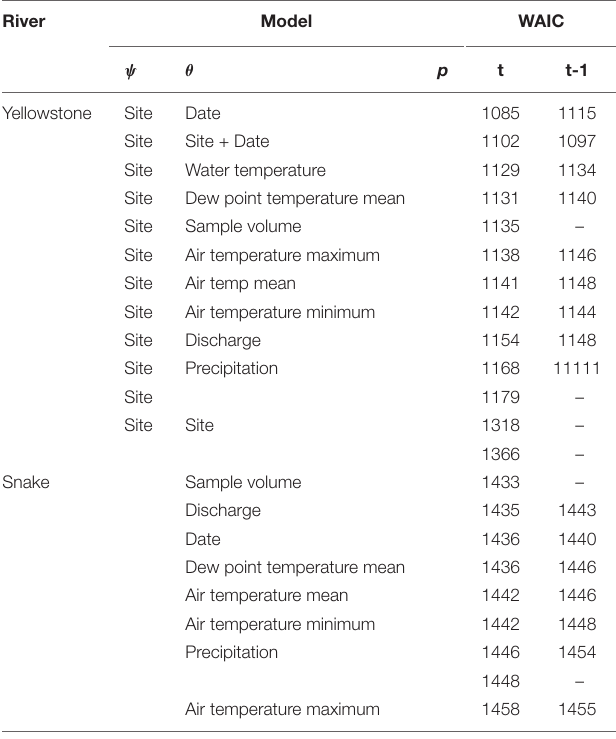
TABLE 2 | Watanabe-Akaike information criterion (WAIC) scores of the Yellowstone and Snake river candidate models. River